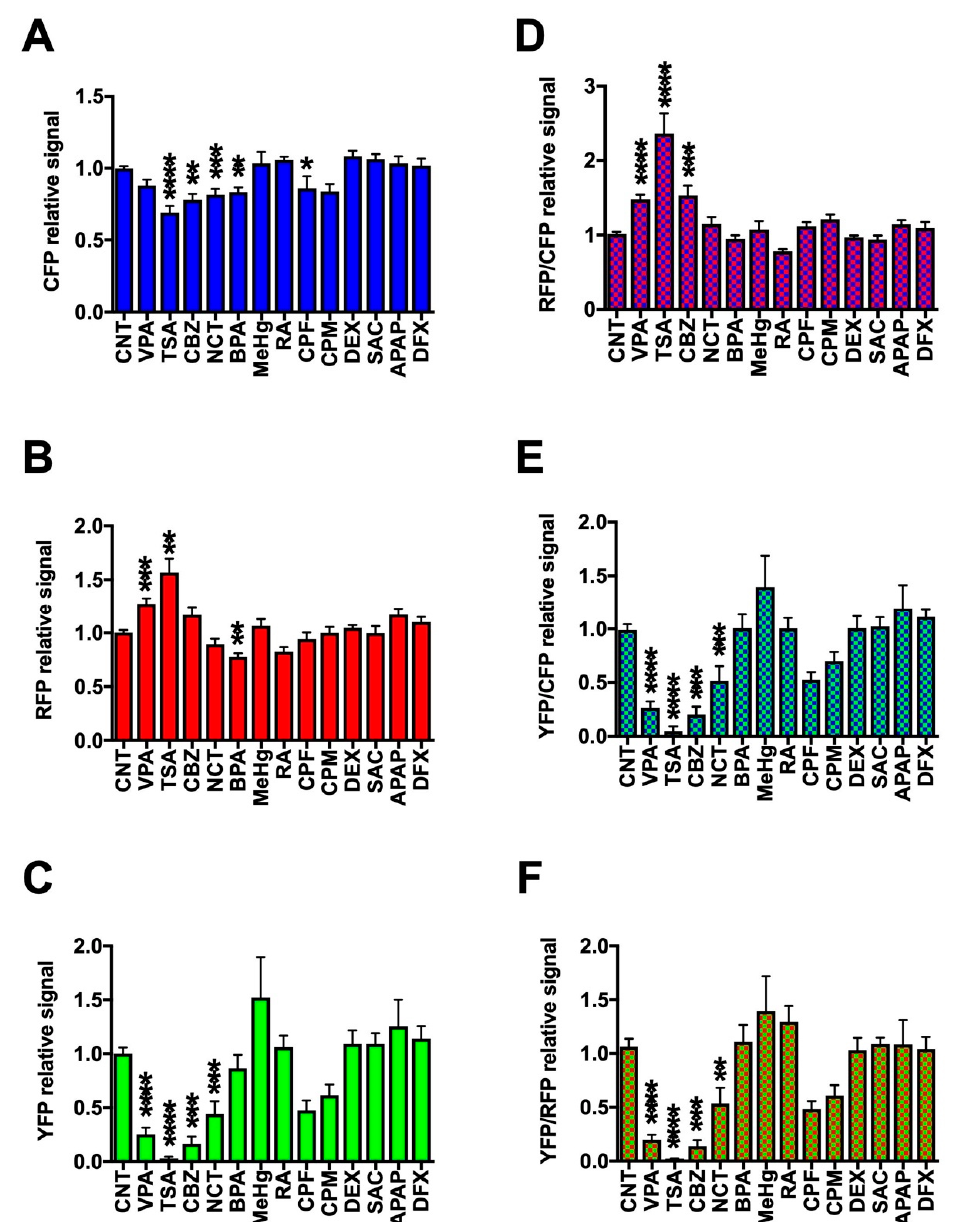
Figure 4. Quantification of in vivo fluorescence imaging of triple-Tg zebrafish exposed to chemicals at the maximum tolerable concentrations during early development. Triple-Tg zebrafish were treated as described for Figure 3 and subjected to in vivo fluorescence imaging at 5 dpf. The fluorescence signals for CFP ( A ), RFP ( B ), YFP ( C ), RFP/CFP ratio ( D ), YFP/CFP ratio ( E ), and YFP/RFP ratio ( F ) were quantified and normalized to the mean signals in the untreated control zebrafish group (CNT). * p < 0.05, ** p < 0.01, *** p < 0.001, **** p < 0.0001. Data are presented as the mean ± SEM of 4–77 zebrafish/chemical.